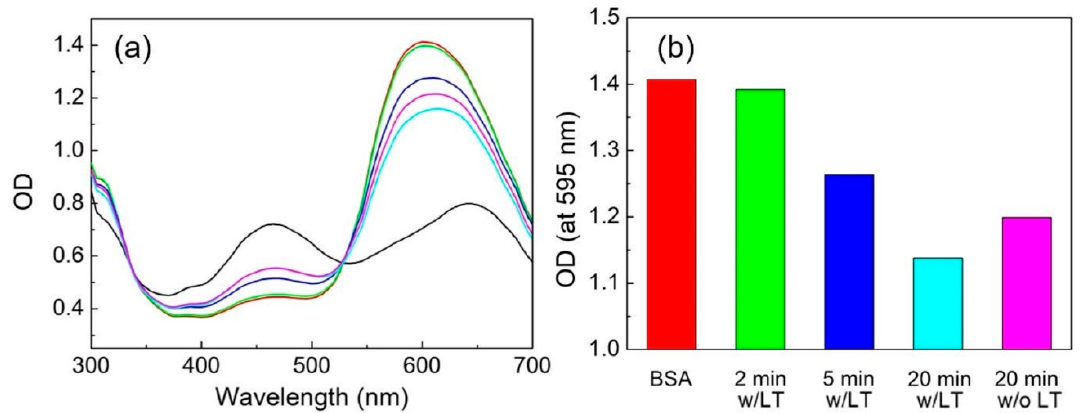
Figure 7. ( a ) Absorption spectra of BSA during reaction with Coomassie blue (g250) in a liquid medium. BSA was obtained from the reaction with Au/ZnPP electrodes w/LT for 2 (green line), 5 (blue line), and 20 min (light blue line); w/o LT for 20 min (pink line), BSA (red line), and DI water (black line). ( b ) Optical density (OD) of BSA from ( a ) at an absorption wavelength of 595 nm.